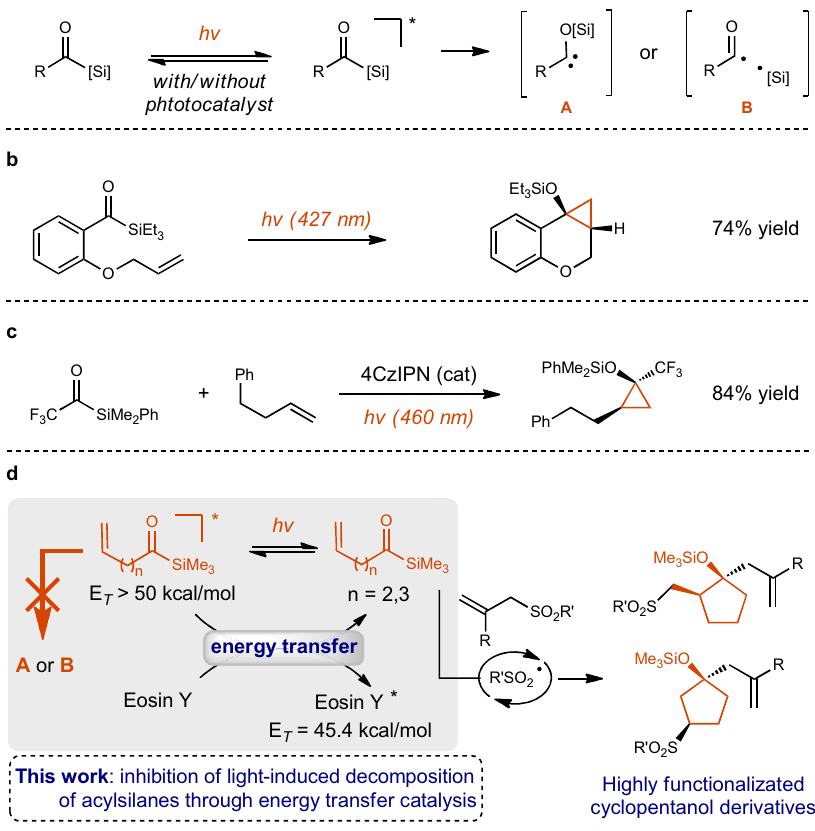
Fig. 1 | Background and our strategy for the synthesis of cyclopentanols enabled by inhibition of light-induced decomposition of acylsilanes through energy transfer catalysis. a Previous work: acylsilanes are unstable under light irradiation. b Priebbenow ’ s intramolecular [2+1] cyclization of acylsilanes with